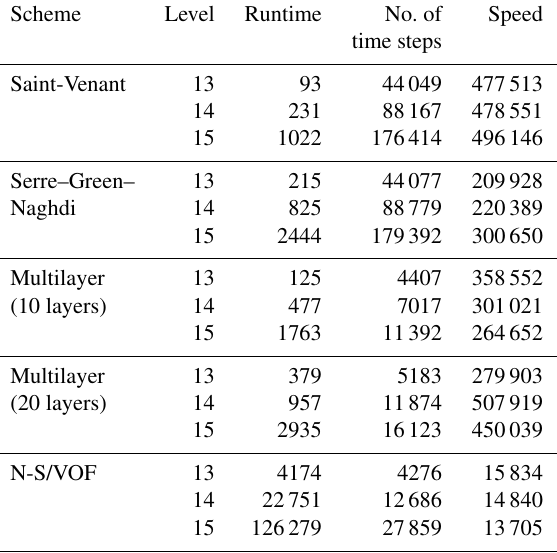
Q = 0 . 0914m). Runtime in seconds and speed in points × time steps × layers per second per